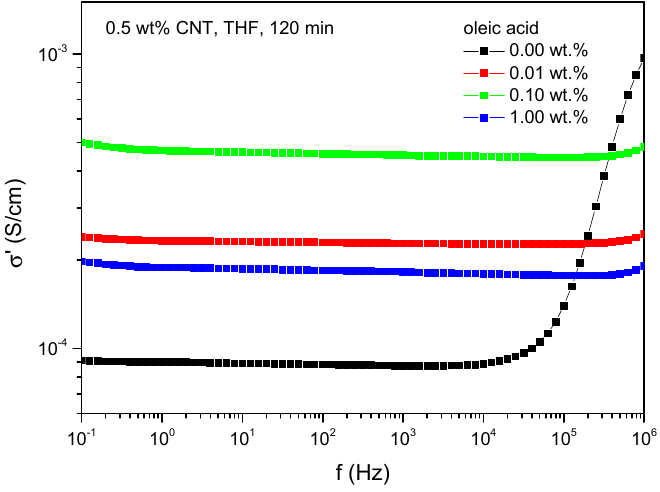
Figure 5. Dielectric conductivity depending on oleic acid concentration.